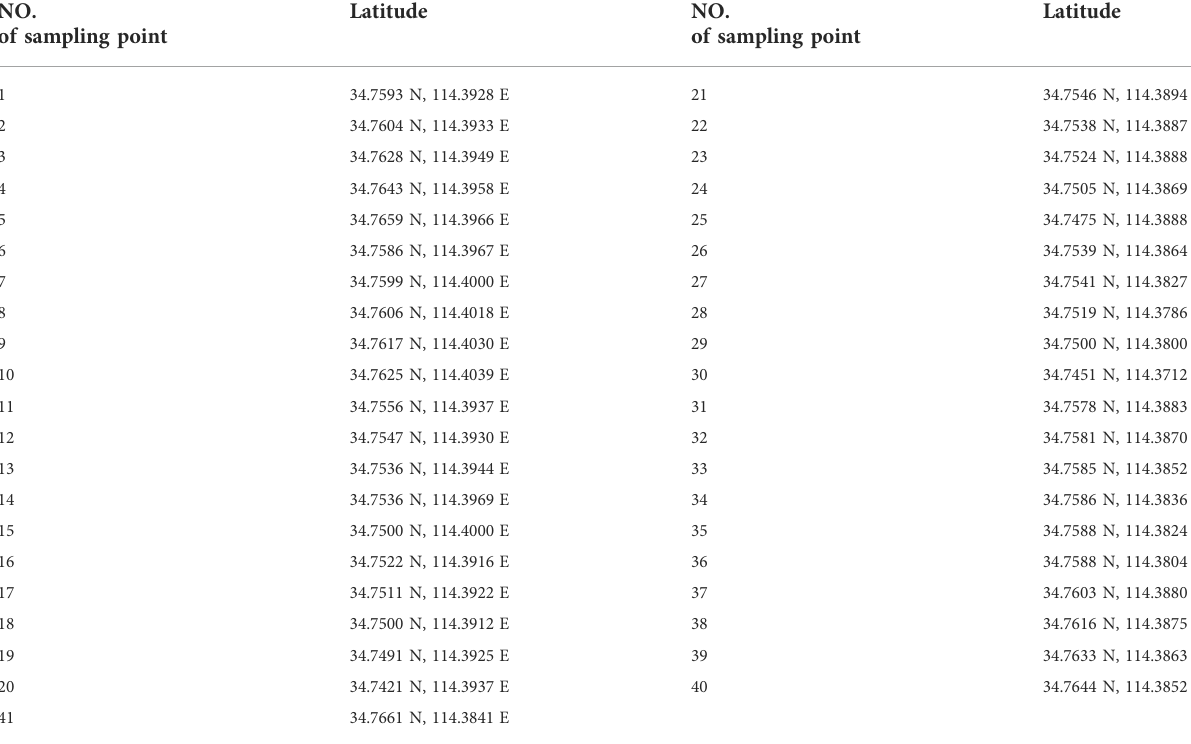
TABLE 1 Coordinates of the sampling point.